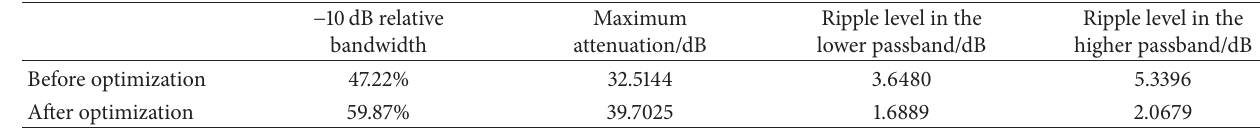
Table 8: Data of papilionaceous dual-plane EBG before and after optimization.